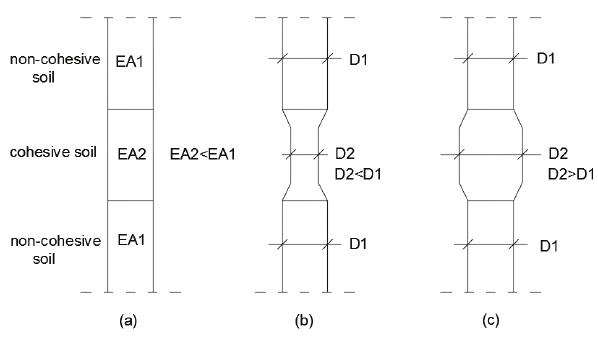
Fig. 1. Pile deformations: (a) lower stiffness value in one of the pile sections, (b) pile diameter local necking, (c) pile diameter local